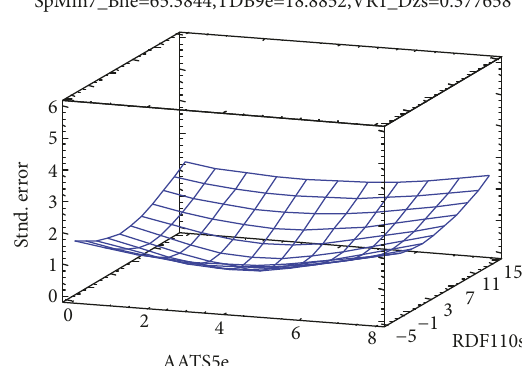
Figure 6: Variance plot shows how the standard error of the predicted response varies across the design region.